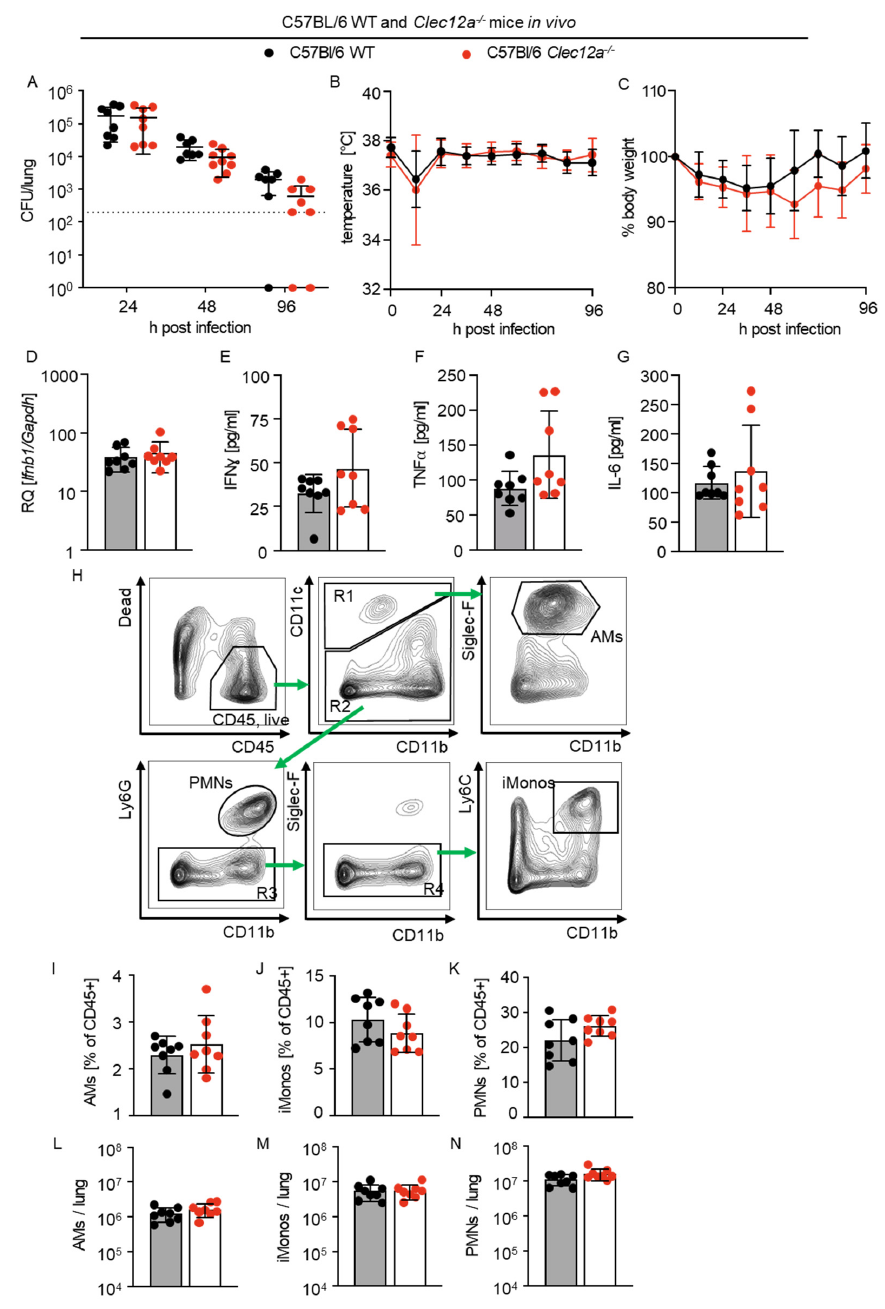
Figure 4. CLEC12A plays a limited role in lung infection by L. pneumophila in mice. ( A ) WT and Clec12a − / − C57BL/6 mice were infected with L. pneumophila at a dose of 10 6 CFU/mouse, and the bacterial loads from their lungs were assessed at 24, 48 and 96 h after infection by plating serial dilutions of homogenized lungs on BYCE agar. ( B , C ) Infected WT and Clec12a − / − C57BL/6 mice were monitored for temperature ( B ) and body weight ( C ) over the course of the infection experiment. The expression levels of Ifnb1 in homogenized murine lungs 24 h after infection were assessed by qRT-PCR and normalized to the lungs of PBS-treated WT mice ( D ). ( E – G ) The levels of IFN ɣ, TNF ⍺ and IL-6 in mouse lungs were measured 24 h after infection. ( H ) Representative flow cytometric analyses